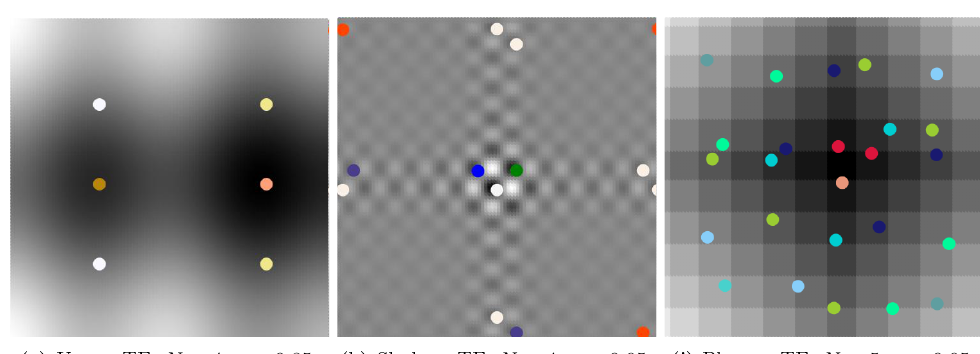
count) and it is not a problem, because cluster- ing by Euclidean distance delete sub-local pop- ulation. But one sub-local extremum localized, de(cid:28)ned by light-green color. This can be cor- rect by changing a parameter. When SOMA try (cid:28)nd plurality of extrema in not ME TF it gets sub-local clusters as seen on Fig. 2(b). Figure 2(c) is good demonstration of deleting sub-local extrema by varying a parameter. A